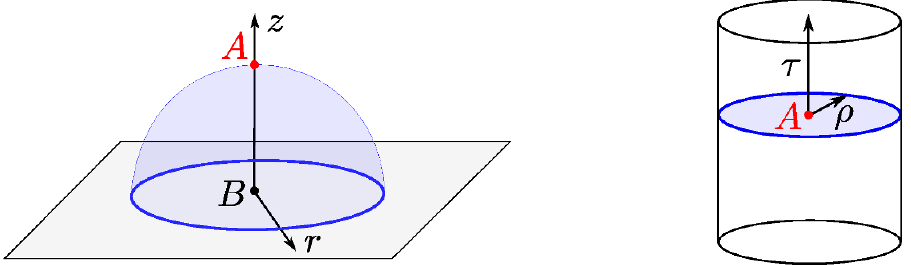
Figure 1 . Hyperbolic space in Poincar(cid:19)e coordinates (left) and global coordinates (right). Surfaces p of constant (cid:28) correspond to hemispheres of radius z 2 + r 2 = e (cid:28) in the right picture. The boundary point B corresponds to (cid:28) = (cid:0)1 in global